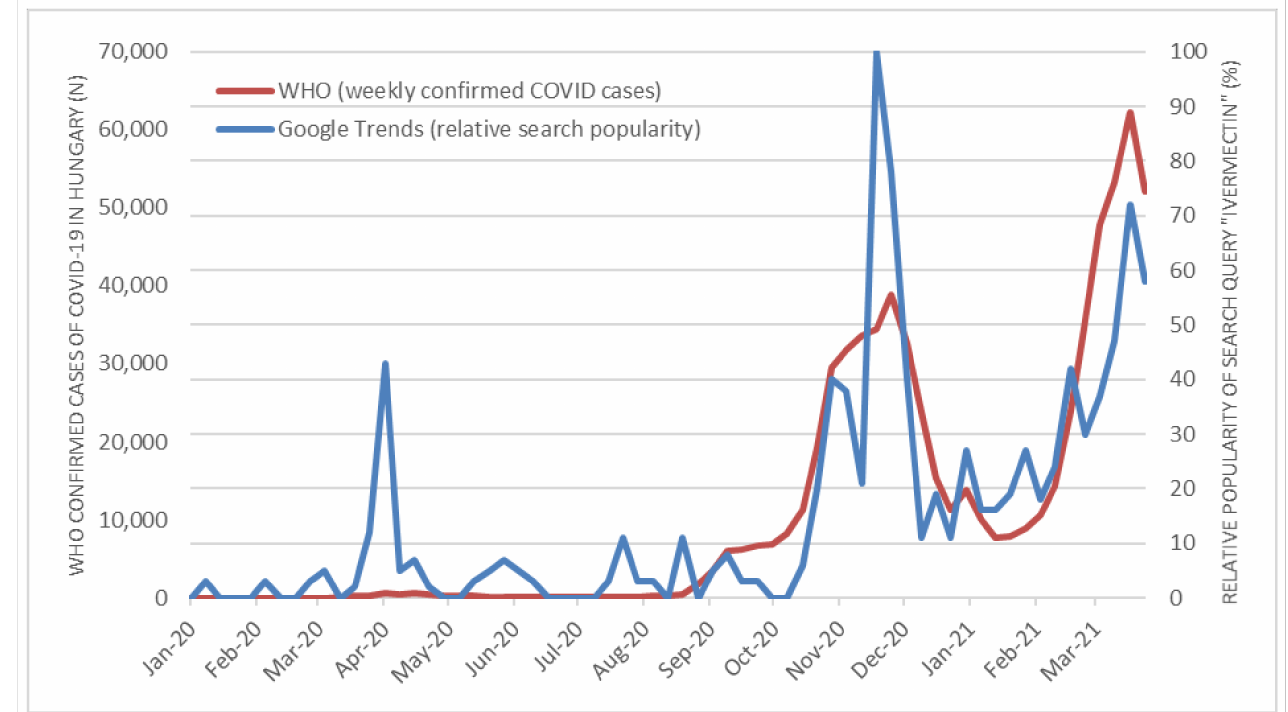
Figure 1. Trend analysis of infoveillance